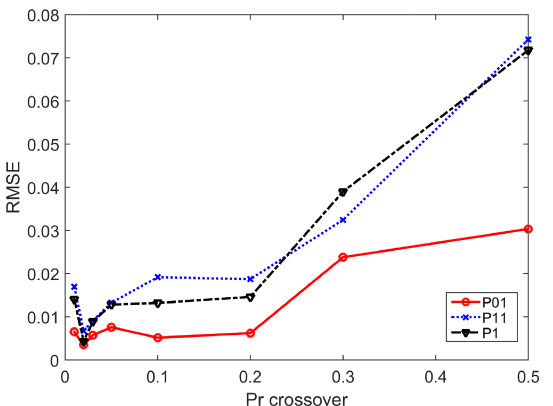
Figure 3. Testing for different probabilities of mutation P m . RMSE is estimated for all the tested 12 stations for each transition and limiting probability of the simulated data with the record length of